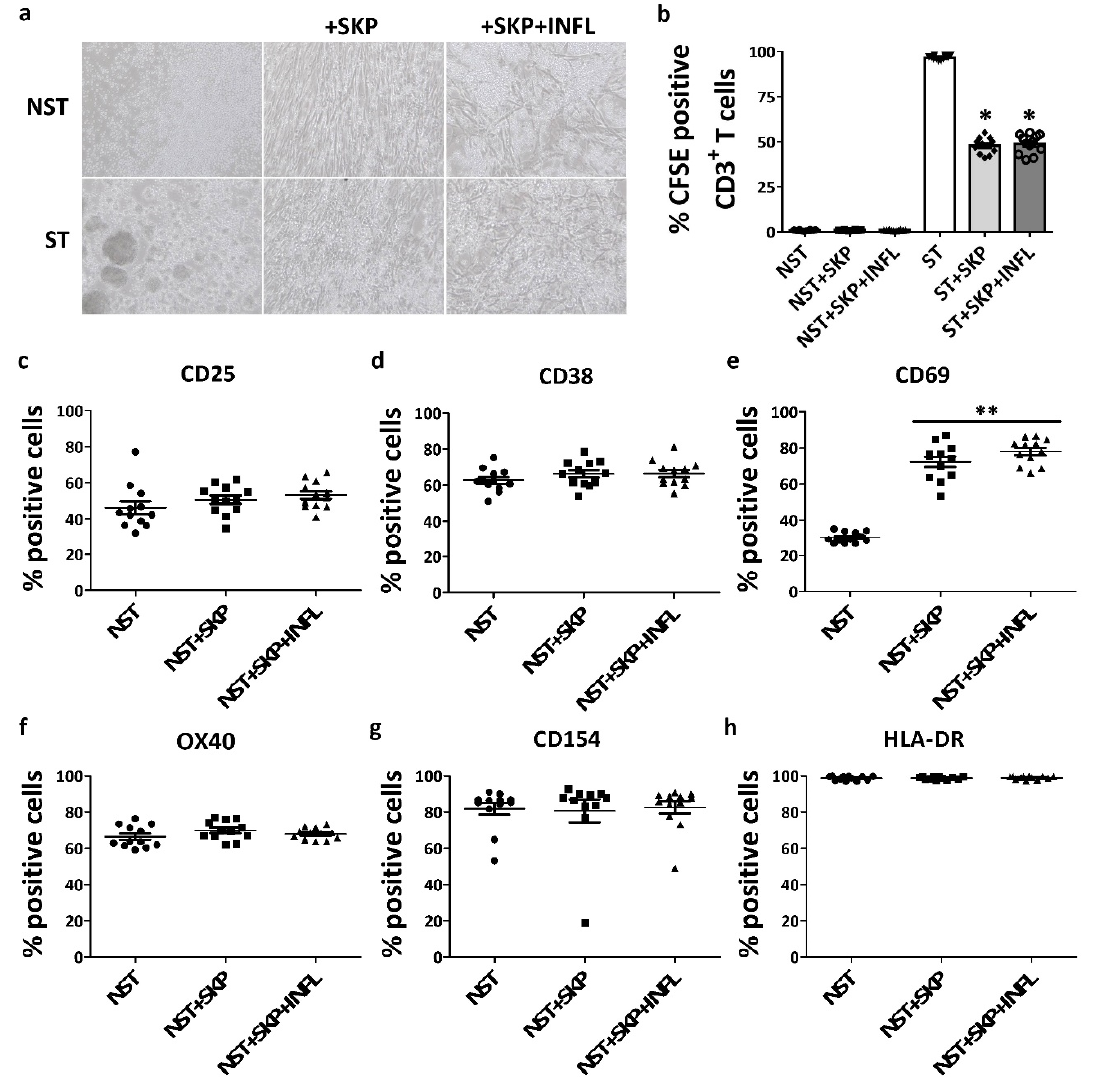
Figure 4. Inflammation does not alter the immunogenicity and immunosuppressive capacity of SKP towards T-cells. ( a ) Micrographs (100 X) and ( b ) flow cytometric quantification of CSFE-positive CD3 + T-cells in cocultures of CD3 + not-stimulated (NST) or stimulated (ST) T-cells with SKP with and without pro-inflammatory induction. ( c – h ) Flow cytometric analyses of the expression of immune regulatory molecules by NST in the presence or absence of SKP with and without pro-inflammatory induction. The values are expressed as mean ± SEM and originate from at least four di ff erent SKP donors and four di ff erent T-cell donors. * Significantly decreased percentage versus ST ( p -value < 0.05); ** Significantly increased percentage versus NST ( p -value < 0.05).